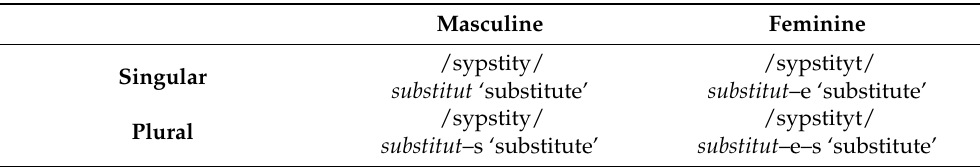
Table 1. Gender and Number Distinctions in Written and Oral French.